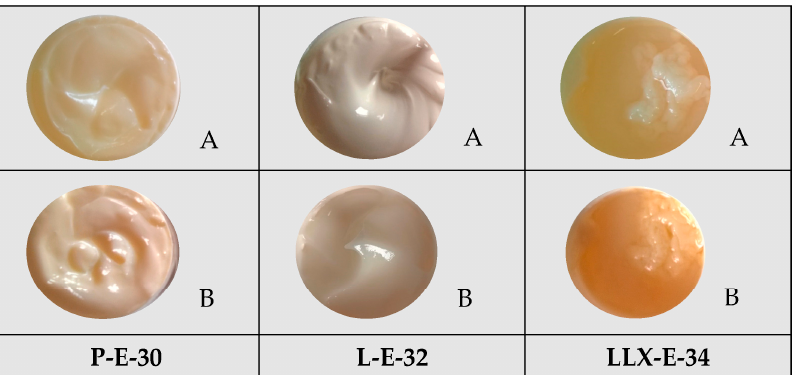
Figure 2. Pictures of selected ointments with benzocaine—after preparing them ( A ) and after 28 days ( B ).